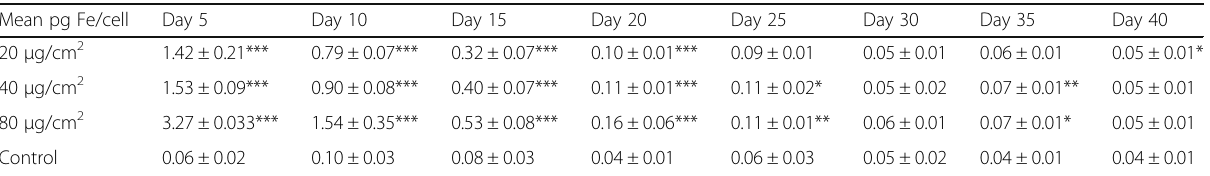
Table 2 Long-term cellular iron quantification Mean pg Fe/cell